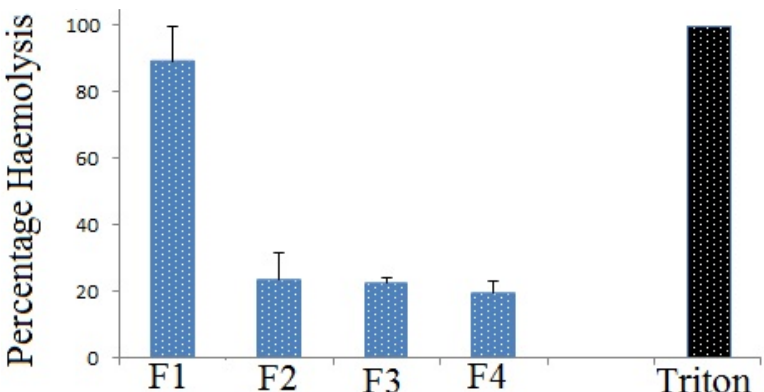
Figure 2. Hemolytic action of ethanol extract of foundation lotion on human Red Blood Corpuscles.